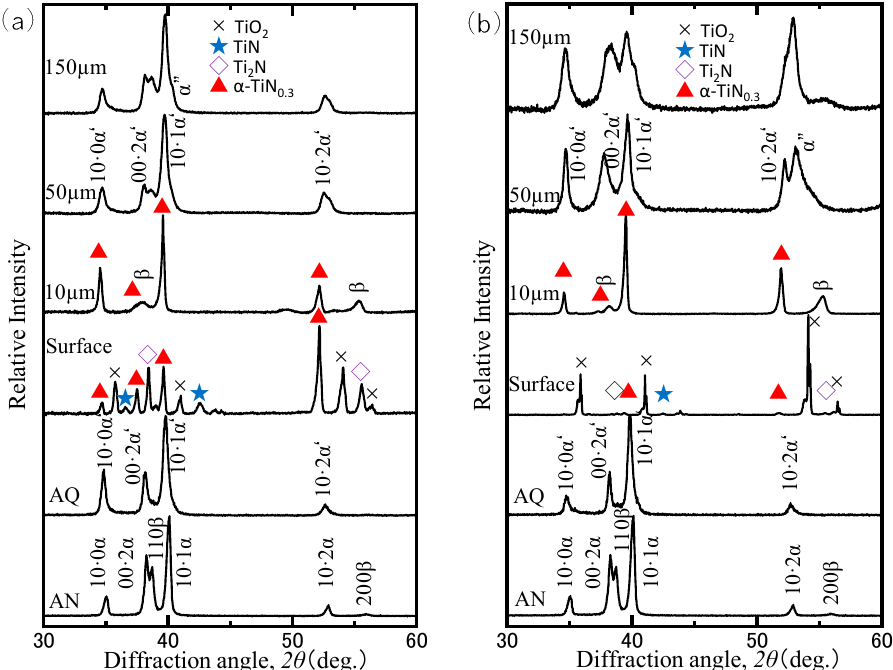
Figure 3. Change in the XRD profile from the surface to the depth direction. ( a ) 1023 K. ( b ) 1223 K.